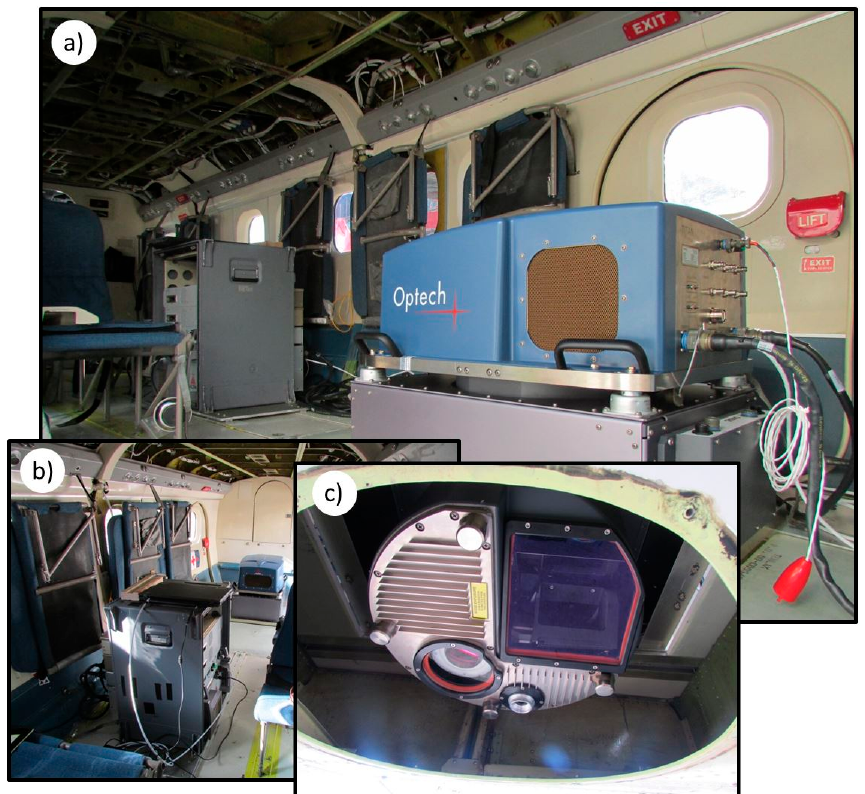
Figure 4. The Titan multspectral lidar sensor integrated into a DHC-6 Twin Otter aircraft: ( a ) Overview of installation layout from the port side of sensor head; ( b ) View from front looking aft, sensor control rack is in the foreground, sensor head in the background; ( c ) View of the sensor head through the mapping port of the aircraft. The laser output window is the rectangular window on the right, and the DIMAC camera lens is behind the circular window.